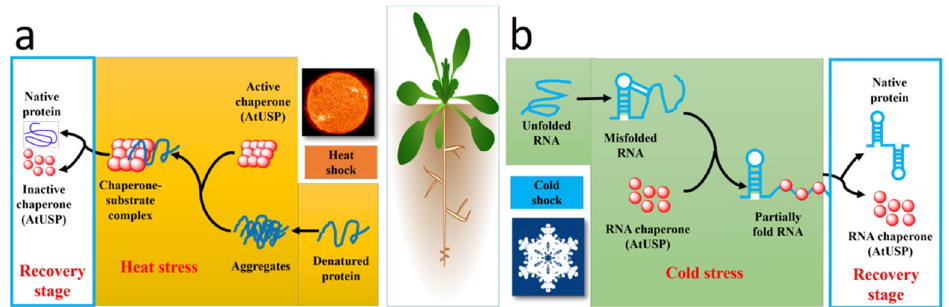
Figure 4. Role of Arabidopsis USPs in different stresses. ( a ) When the environment gives Arabidopsis high temperature stress, At USP functions as a protein chaperone in the cell, it changes from a low molecular weight complex (LMW) to a high molecular compound (HMW) and binds to proteins that cannot function properly because of high temperature aggregation, helping it to restore its active state after At USP reverts back to the LMW state. ( b ) When subjected to cold stress, At USP binds as an RNA chaperone to RNA fragments misfolded by low temperature and helps them to open the misfold and restore the correct fold.